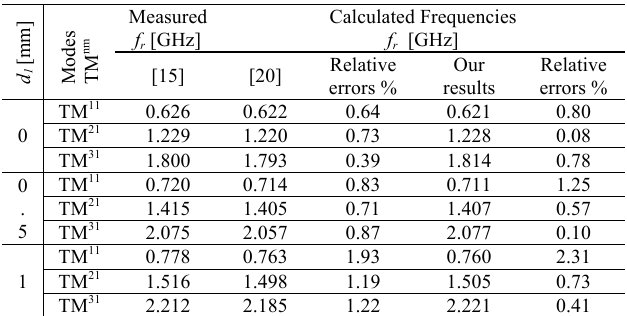
Table 2: Comparison of measured and theoretical resonant frequencies for, r